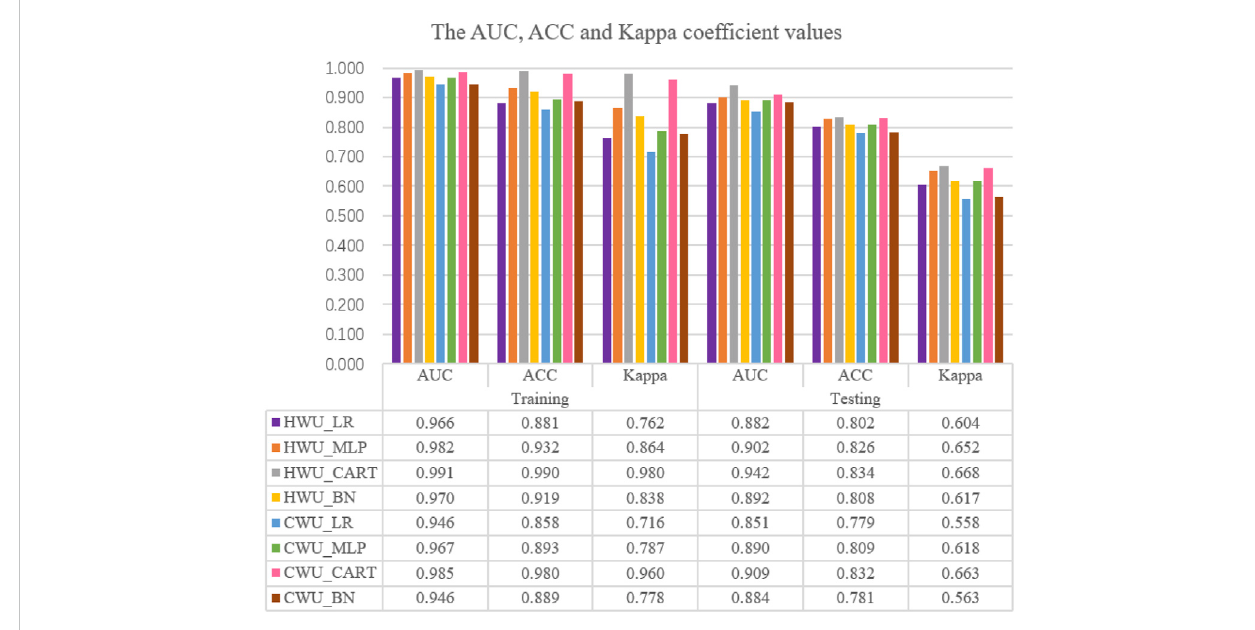
FIGURE 10 The AUC, ACC, and Kappa coef fi cient values of the eight models for the training and testing